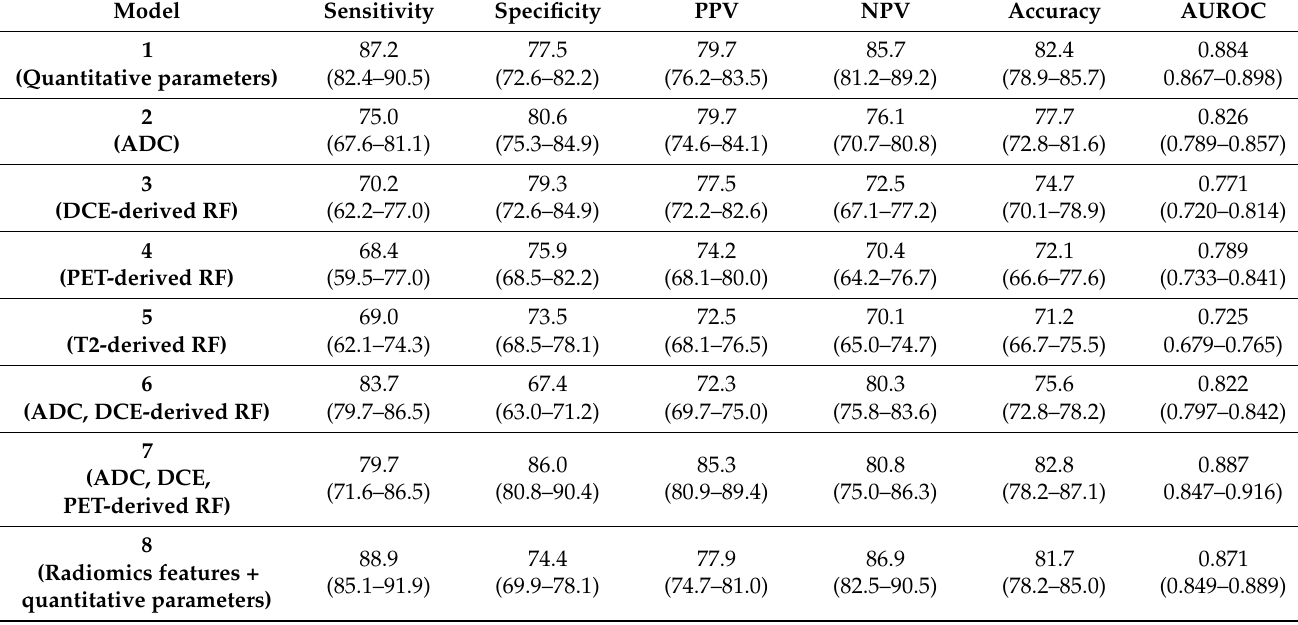
Table 2. Diagnostic accuracy of the eight developed radiomic